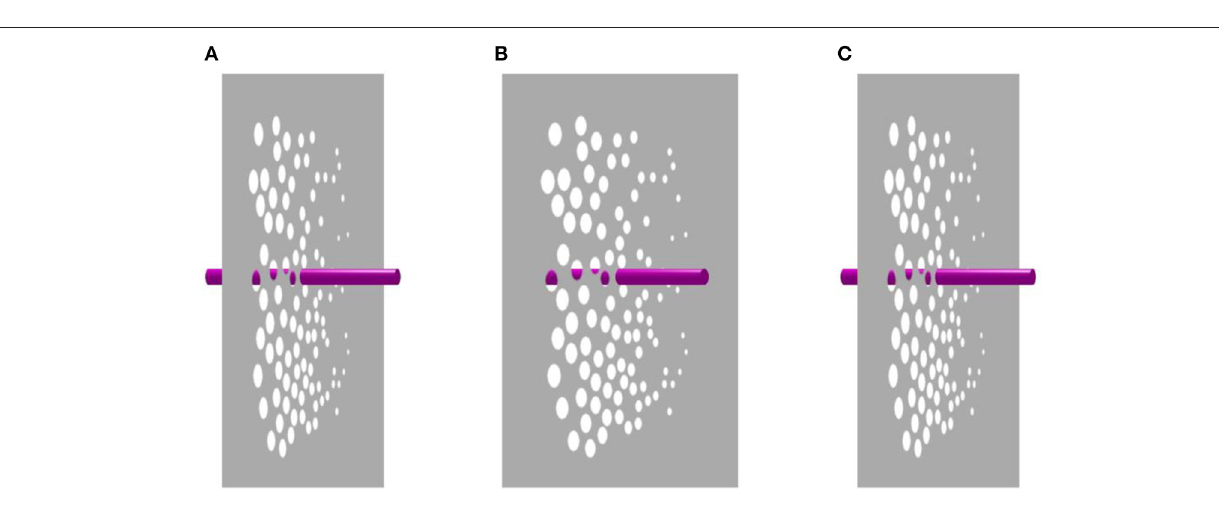
FIGURE 4 | Amodal completion of the occluded rod. Both the window and the crimson rod appear to rotate through 360 ◦ . The occlusion relationships provided by the circular holes overrides relative size cues to depth. Panels (A) and (C) are identical, while panel (B) contains disparity. Please see Supplementary Video 4 for an